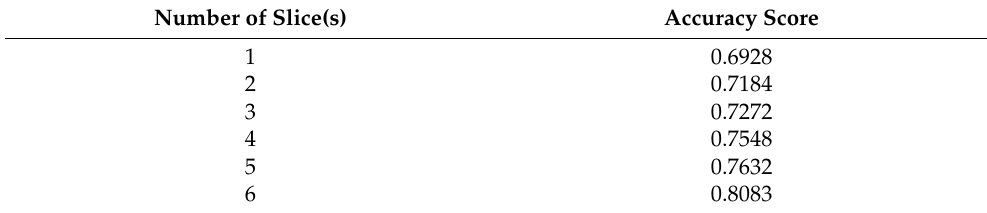
Figure 5. Examples of 2D thickness images for ( a ) 1-slice, ( b ) 2-slice, ( c ) 3-slice, ( d ) 4-slice, ( e ) 5-slice, and ( f ) 6-slice. Table 6. Accuracy results of EfficientNetB1 (pre-trained, dropout, augmented) with various short-axis slices on the validation set.